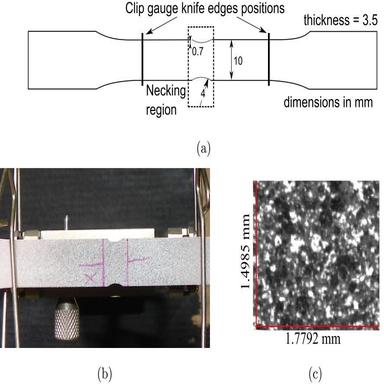
PVC specimen (a) representation of the principal machined dimensions, and images of the (b) specimen mounted in the tensile testing machined and (c) speckle pattern.